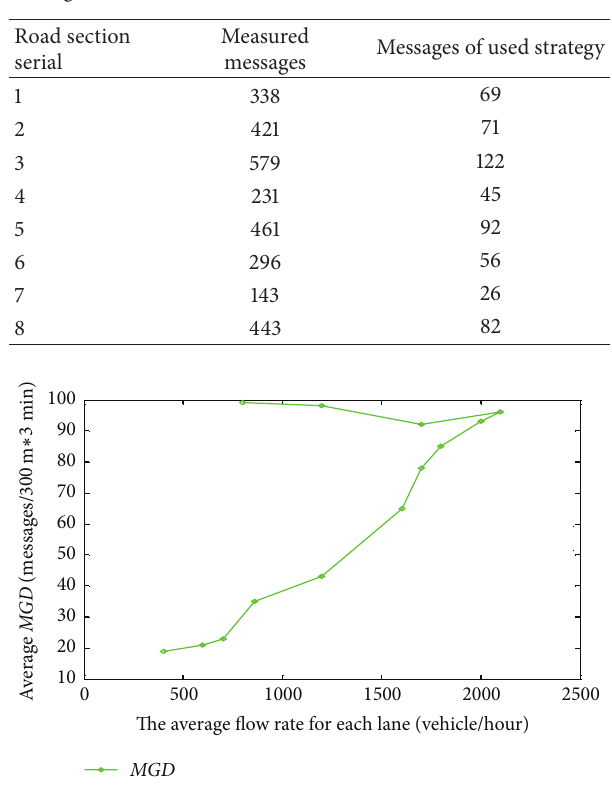
Table 2: Comparison of measured messages and used strategy messages.